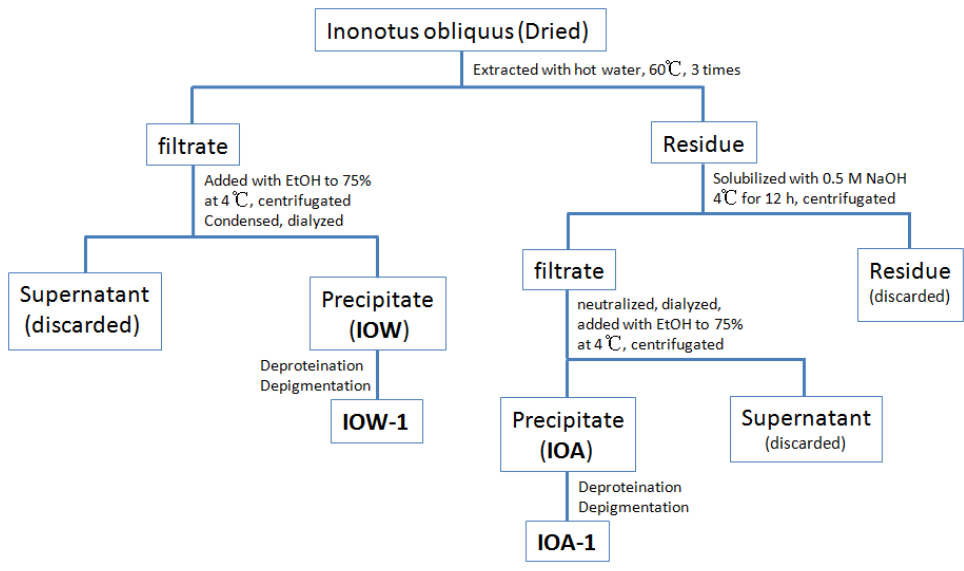
Figure 6. Preparation of crude polysaccharides from I. obliquus